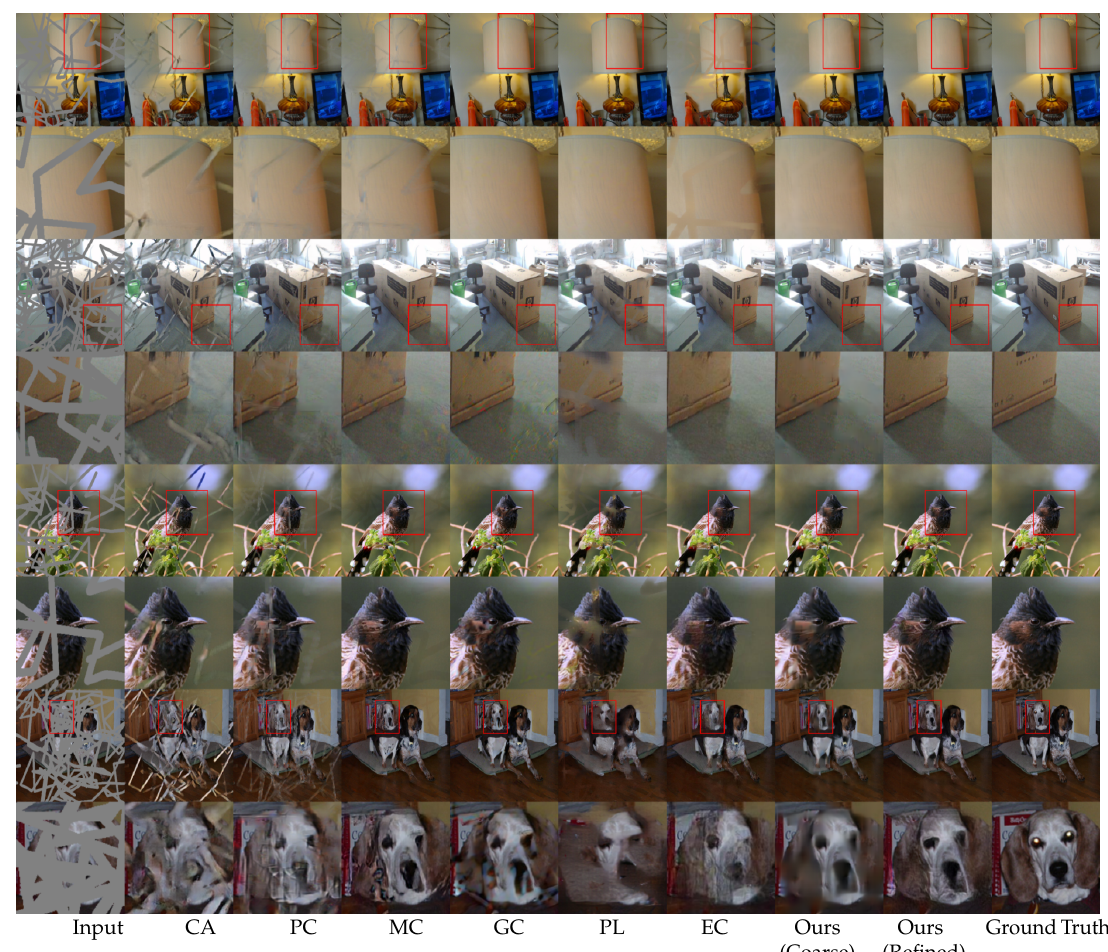
Figure 7. Qualitative comparison on ImageNet [22] dataset. From the left: input, CA [14], PC [17], MC [18], GC [16], PL [39], EC [19], proposed method (coarse output), proposed method (refined output), and the ground truth. Our model generates realistic and consistent structures and textures for larger